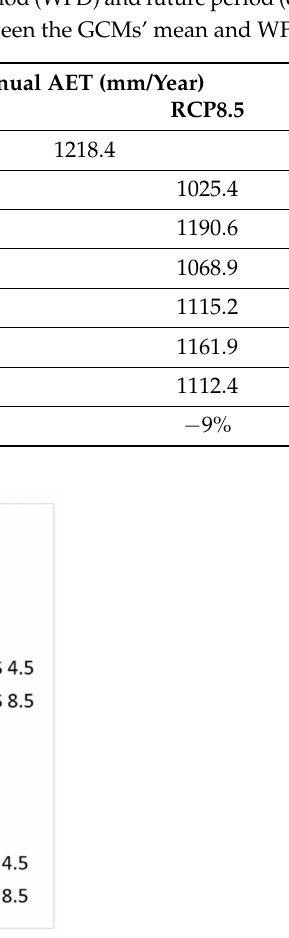
Figure 8. Mean annual evapotranspiration AET (mm/year) for each GCM and both scenarios in the